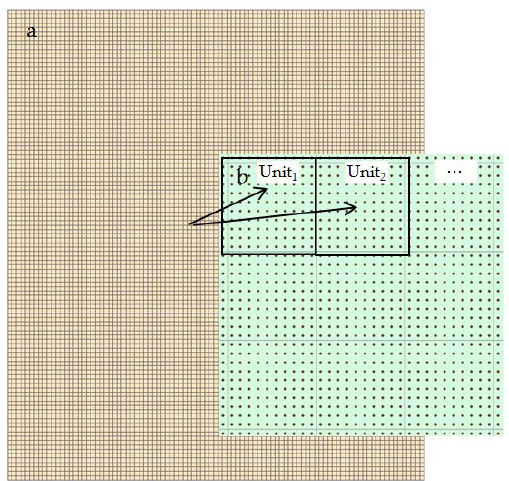
Figure 4. Unit divisions of the geological grid: ( a ) regional grid units; ( b ) information points in each grid unit.